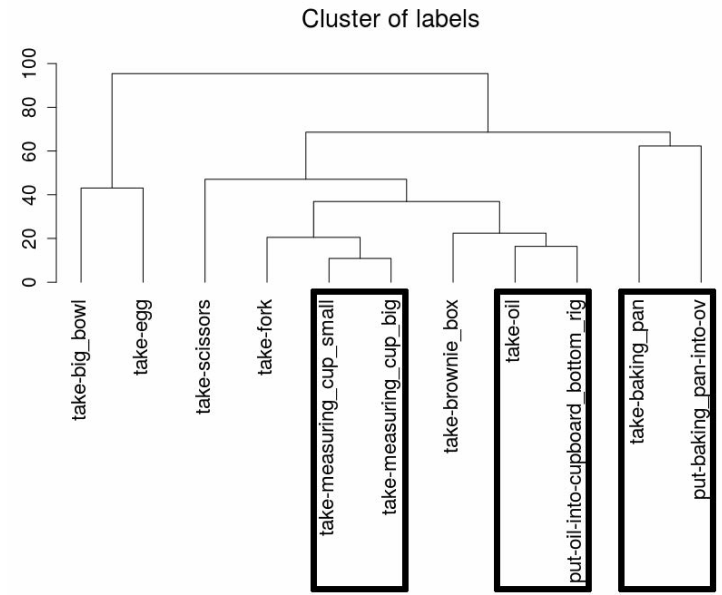
Figure 10. Dendrogram of the clustering of the templates in the kitchen dataset. Marked boxes are activities using the same